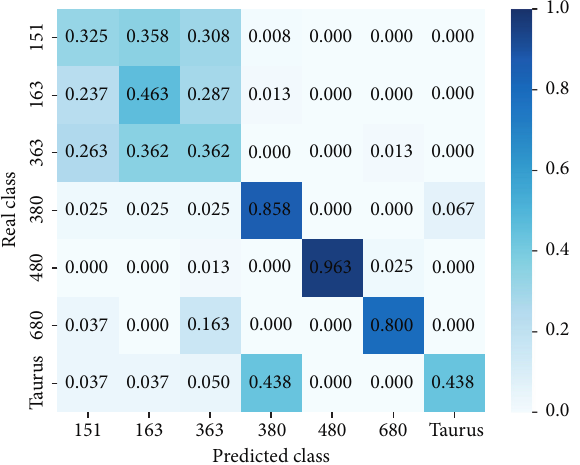
Figure 6: Mean confusion matrix for the best performing CNN for scenario A.